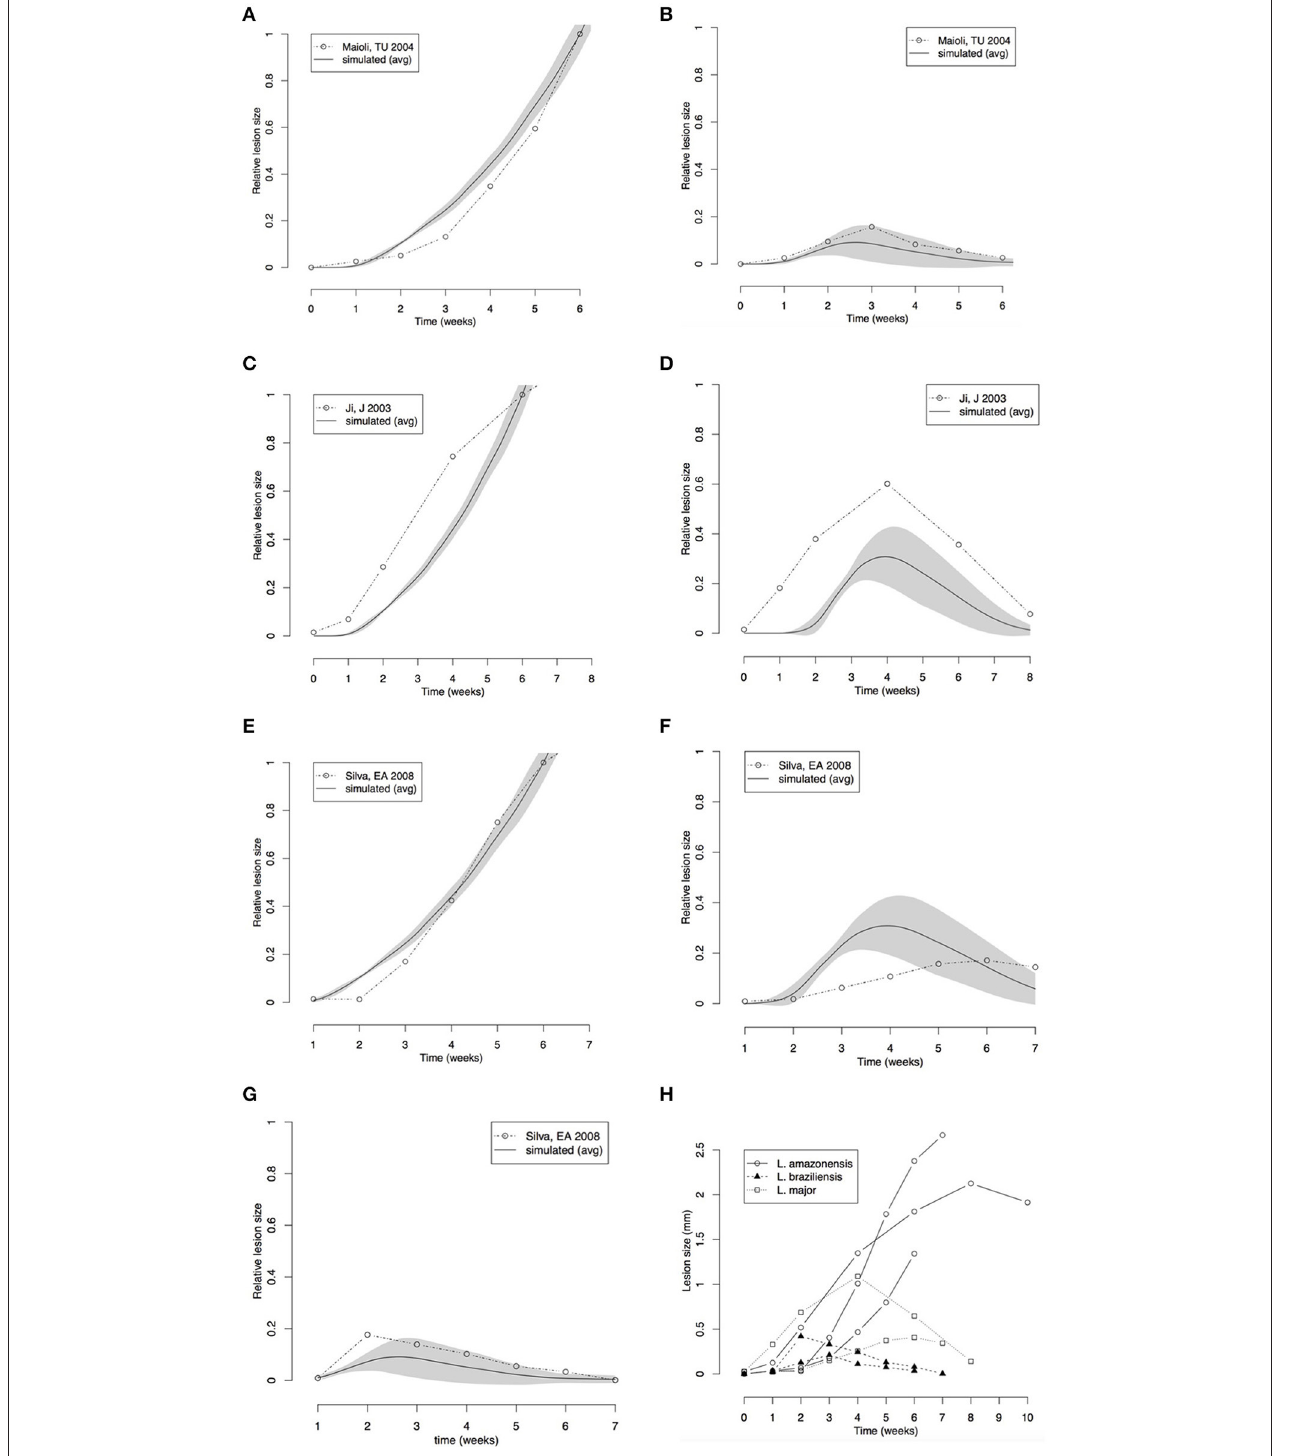
FIGURE 4 | Comparison between lesion sizes in different mouse models of Leishmania infection. (A,B) Comparison with data extracted from Maioli et al. (2004); L. amazonensis (A) L. major (B) . (C,D) Comparison with data from Marques-da-Silva et al. (2008); L. amazonensis (C) , L. braziliensis (D) . (E–G) Comparison with data from Ji et al. (2003); L. amazonensis (E) , L. major (F) , L. braziliensis (G) . (H) Comparison between data extracted from the three papers. All simulation and real data (A–G) were normalized to the size of the L. amazonensis lesion at 6th week. Simulations of the three cutaneous leishmaniasis were conducted with the parameter settings showed in Table 3 . Each plot (A–G) represents the average ± standard deviation (gray area) of 10 simulations.